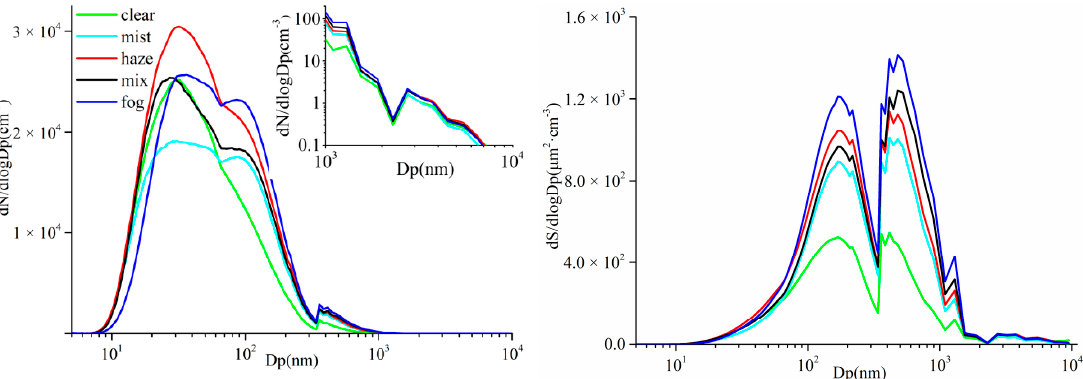
Figure 5. Particle number size distribution (PNSD) and particle surface area size distribution (PSSD) in different processes.